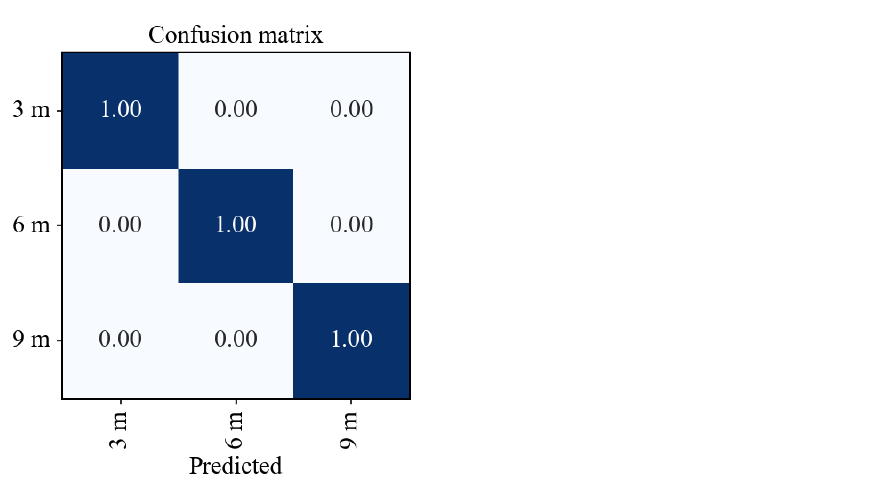
Figure 18. Confusion matrix of RF train on distances between sensor and interference signal.